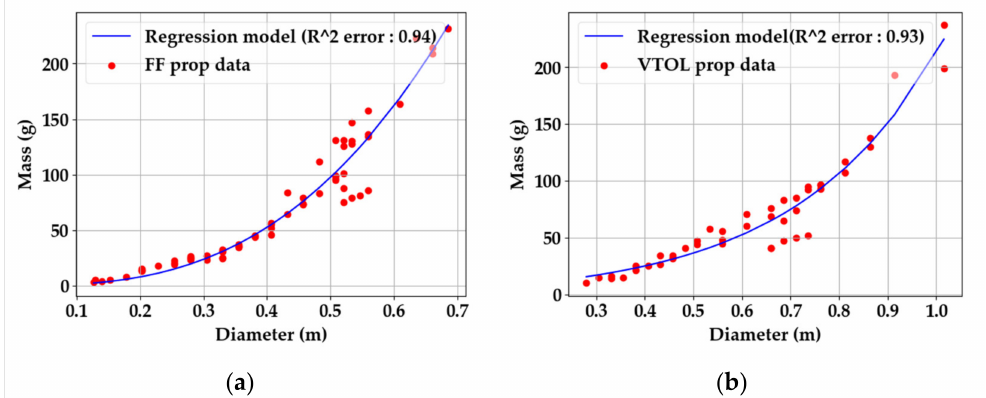
Figure 8. Propeller regression model: ( a ) FF propeller regression model from APC propeller data [26]; ( b ) VTOL propeller regression model from T-motor propeller data [21]. The accuracy of the model was measured by the R -squared error, and the accuracy was high at 0.94 and 0.93, respectively. The unit of the diameter of the propeller is in meters (m), and mass of the propeller is in grams